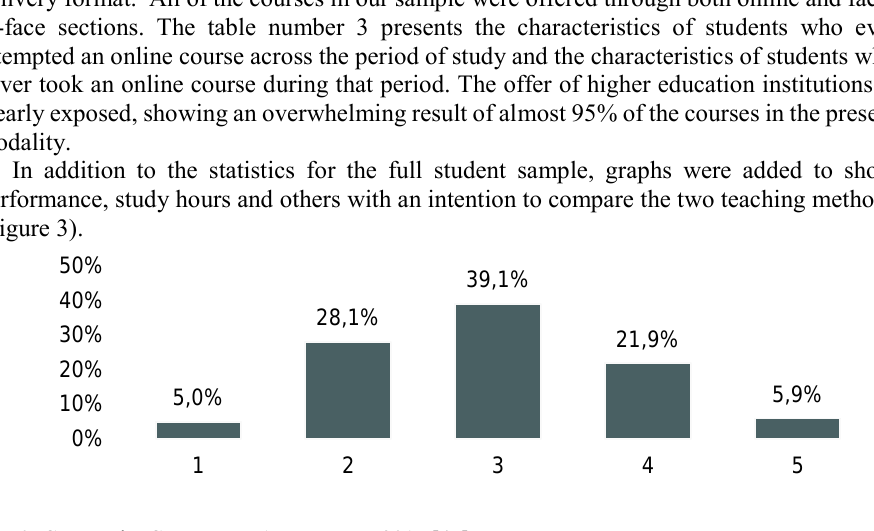
Fig. 3. Courses by Concept ENADE Banner 2017